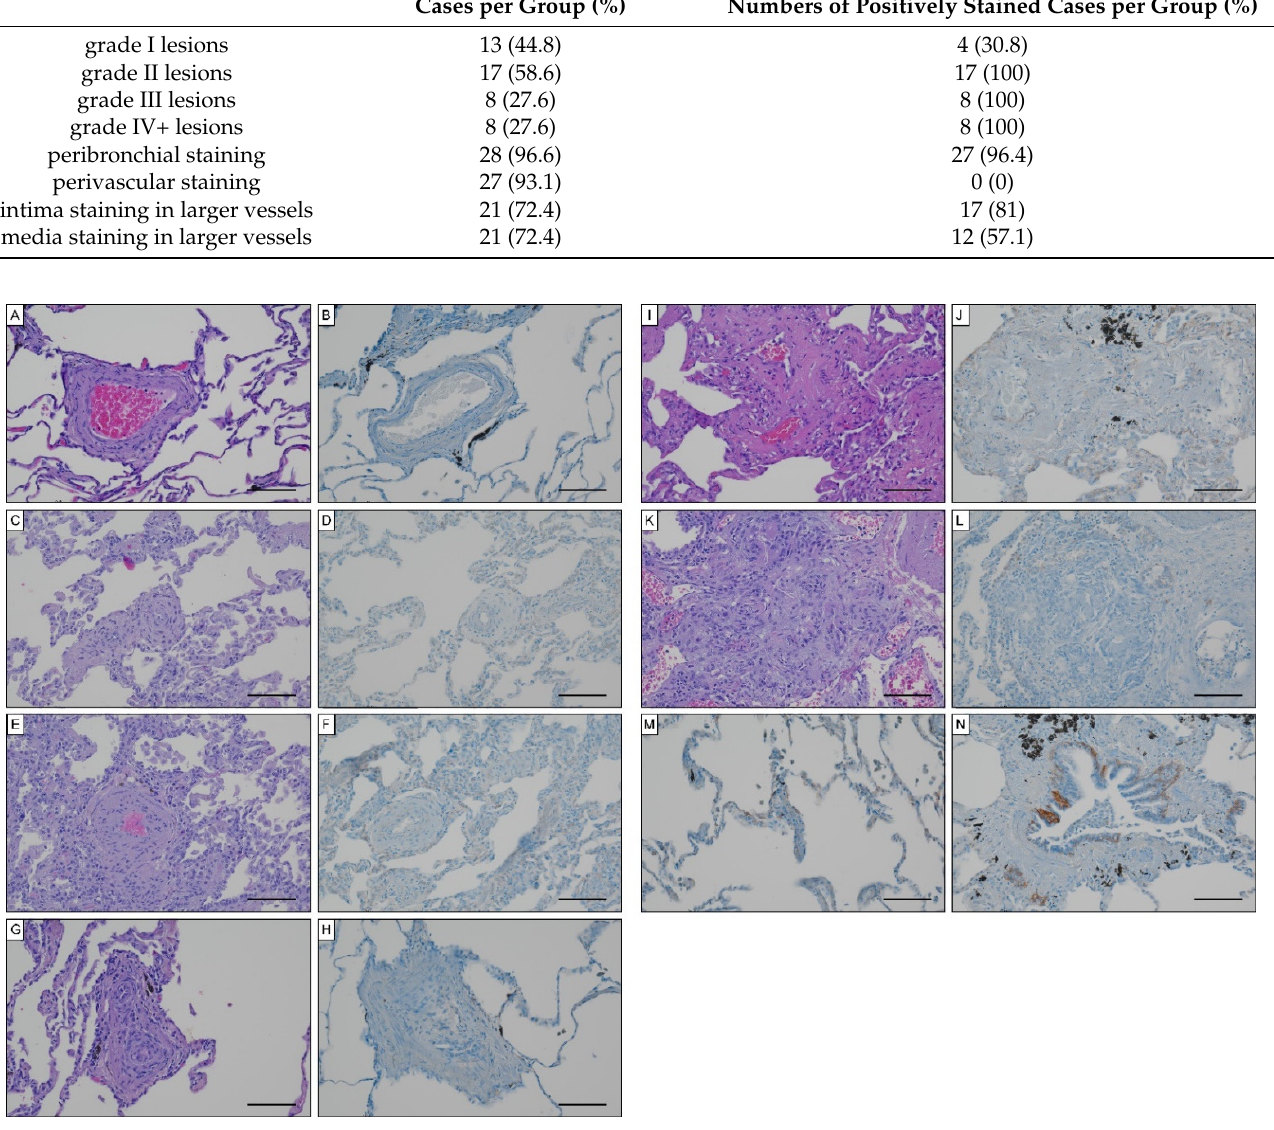
Figure 7. EGFR expression in iPAH specimen. Hematoxylin eosin and EGFR staining in ( A , B ) Heath–Edwards grade I, ( C , D ) grade II, ( E , F ) grade III, ( G , H ) grade IV, ( I , J ) grade V lesions, ( K , L ) plexiform lesions. EGFR staining of ( M ) alveolar pneumocytes and ( N ) basal epithelium of bron- chioles. Scale bars, 100 µm. Table 4. S100A4 expression Heath–Edwards lesions and iPAH lungs (n = 29). Pathological